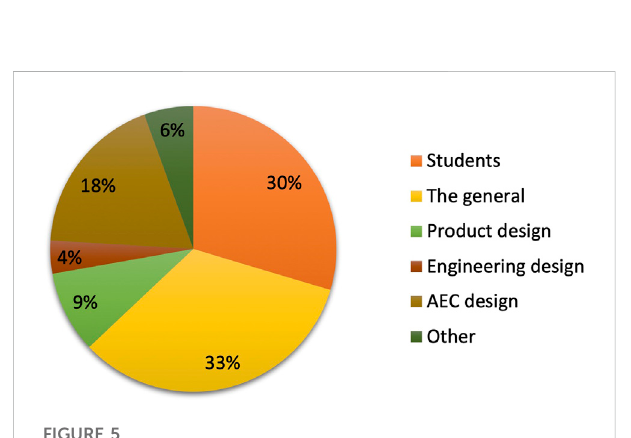
FIGURE 5 Targeted design participants in the publications.